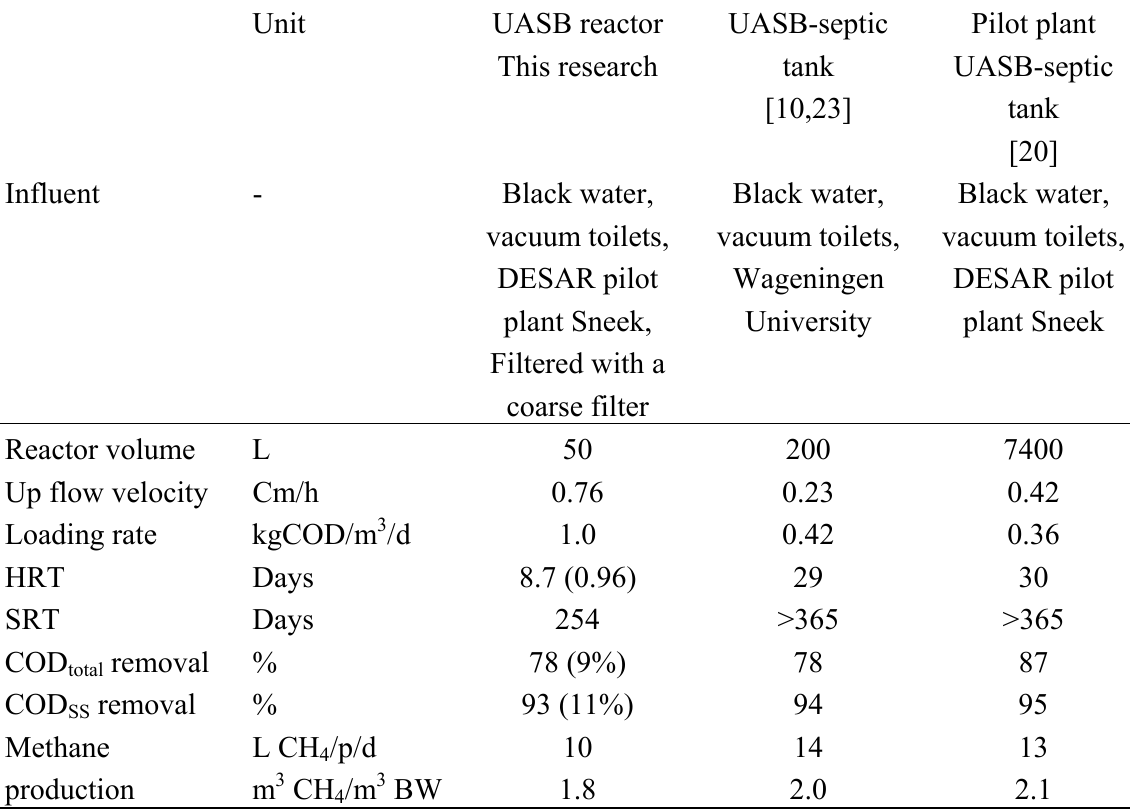
Table 5. Operational characteristics of anaerobic treatment of concentrated black water at 25 °C; (standard